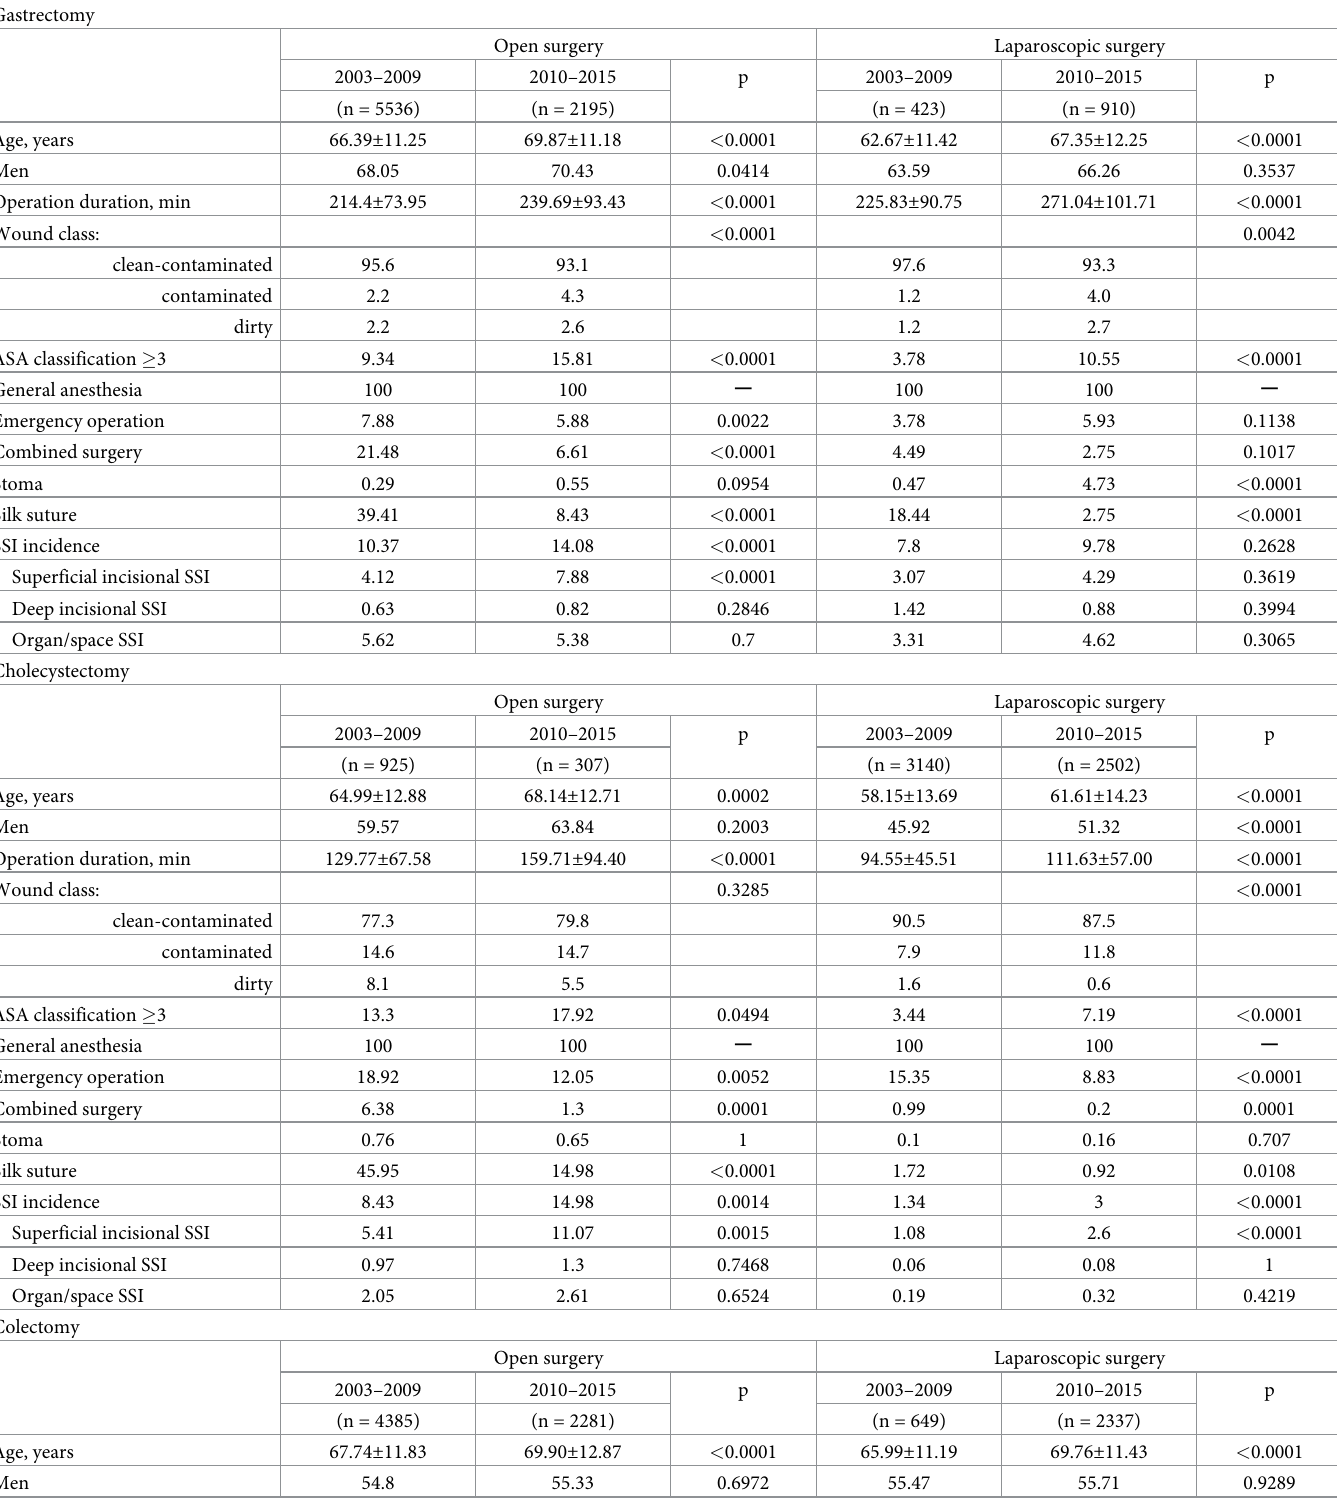
Table 1. Comparison of demographics and clinical characteristics by year of